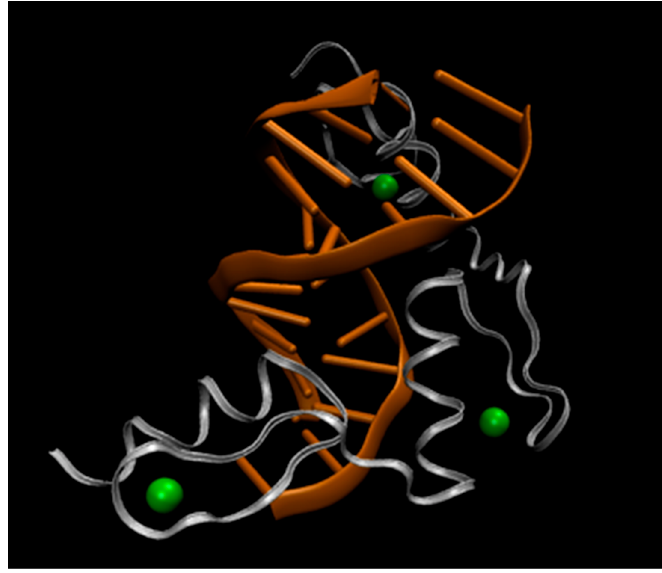
Figure 8. A Zn finger protein domain assisting in DNA transcription, where DNA is colored orange, the protein is gray, and green spheres are Zn. The image was generated with VMD software from PDB file 1A1L [165,166].